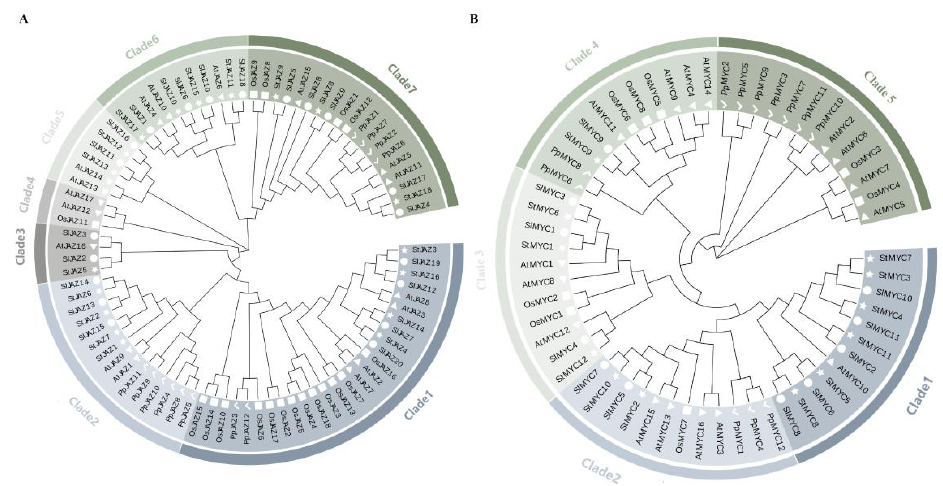
Figure 2. Phylogenetic tree of potato, tomato, rice, Arabidopsis, and physcomitrella patens JAZs and MYCs. ( A ) The Phylogenetic tree of JAZs; ( B ) The Phylogenetic tree of MYCs. Circles represent tomato; the squares represent rice; the triangle represents Arabidopsis; the hooks represent physcomitrella patens; and the stars represent potato.